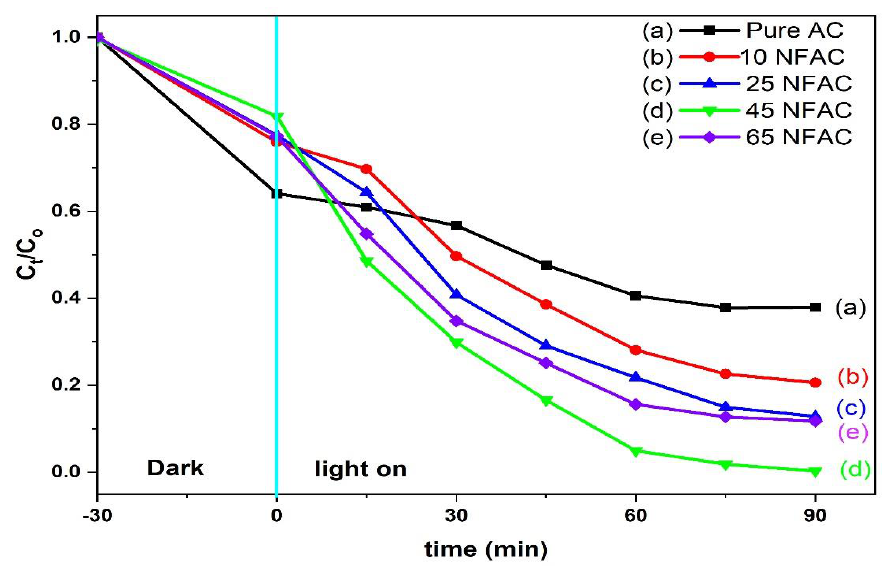
Figure 10. Photocatalytic degradation of rhodamine B over pure and modified activated carbon by different weight contents of NiFe 2 O 4 nanoparticles vs. irradiation time.